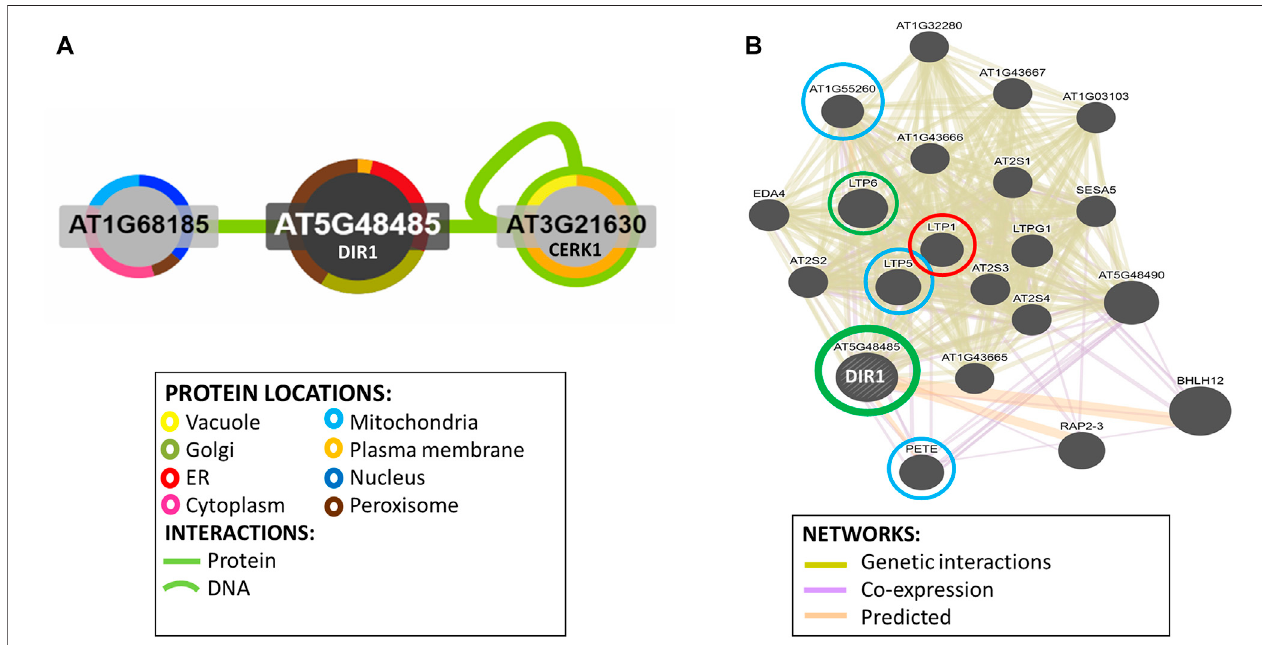
FIGURE 5 | Identi fi cation of potential interacting proteins with DIR1. (A) . Protein interaction image was generated using Interaction Viewer at bar.utoronto.ca/ eplant. Border color indicates protein location. Green lines indicate protein and DNA interactions that have been experimentally determined. (B) . GeneMANIA tool from bar.utoronto.ca/eplantwasusedtopredictothergenes/geneproductsassociatedwithDIR1(AT5G48485).Predicted,co-expression,andgeneticinteraction networks foundassociatedgenes/geneproducts.Proteinsidenti fi edinguardcellsamplesarecircled.Circlecolorsindicateincreased(red),decreased(green),orunchanged (blue) proteins in dir1-1 versus WT Pst -primed guard